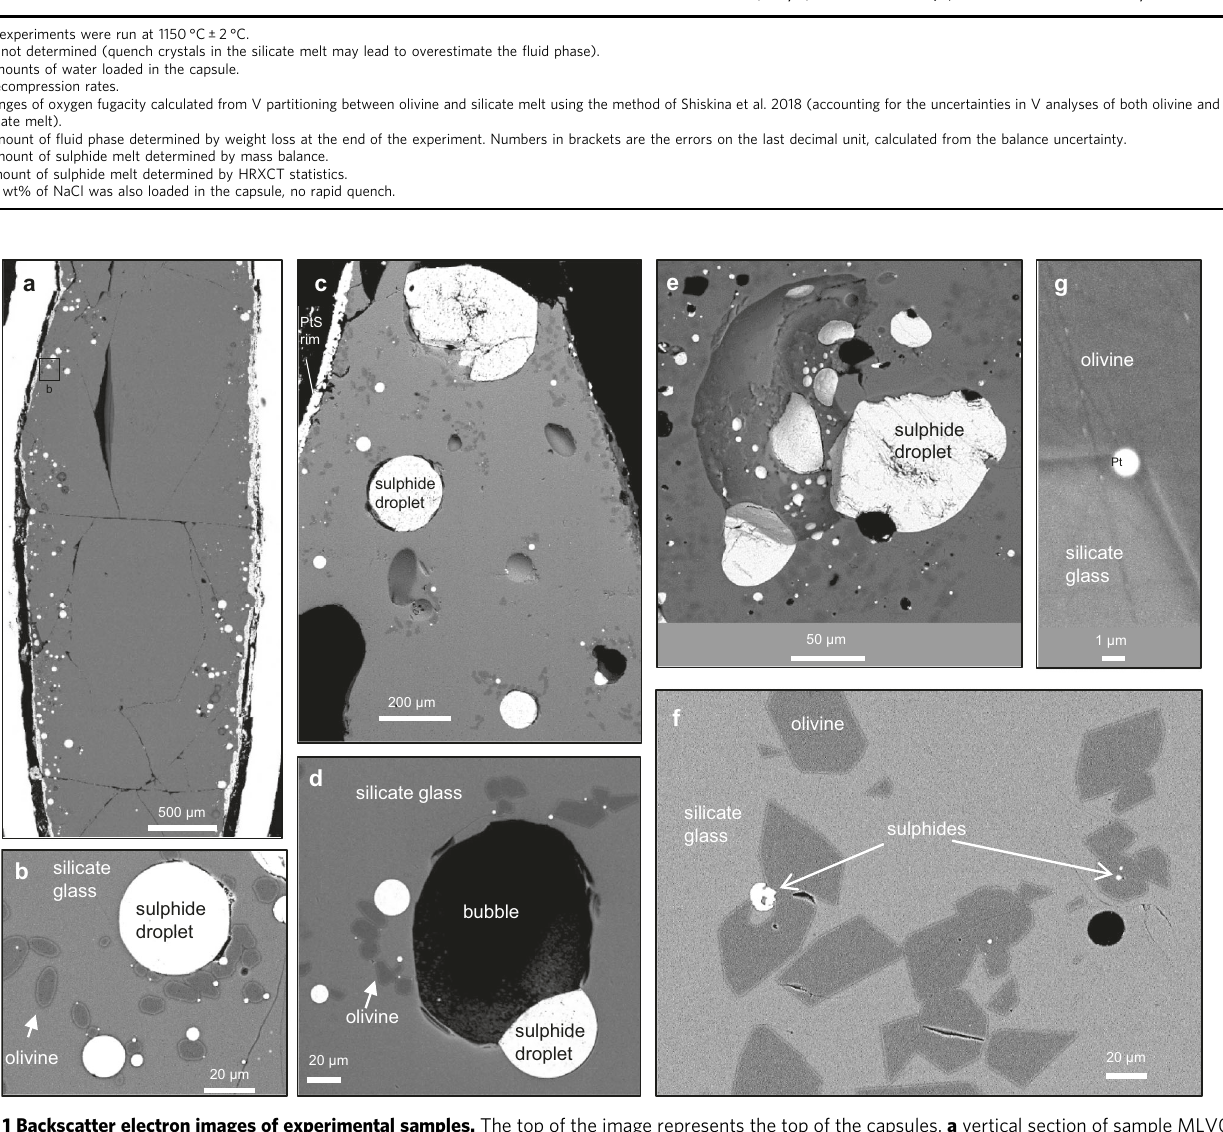
Fig. 1 Backscatter electron images of experimental samples. The top of the image represents the top of the capsules. a vertical section of sample MLV01 that was equilibrated at 200 MPa and did not experience decompression: it presents low amounts of bubbles and sulphide droplets less than 100 µ m in size. b Detailed image of sulphide droplets in MLV01. c Upper part of sample MLV03 that was decompressed from 200 MPa to 50 MPa, containing sulphide accumulations of several hundreds of microns. d Detailed image of a compound drop in MLV03. e Detailed image of a compound drop in sample #6.3. f Sample MLV09 that was decompressed from 320 MPa to 50 MPa. g Detailed image of a Pt-rich phase (Pt) at the interface between the olivine and the silicate melt in MLV09. NATURE COMMUNICATIONS| (2022) 13:2359